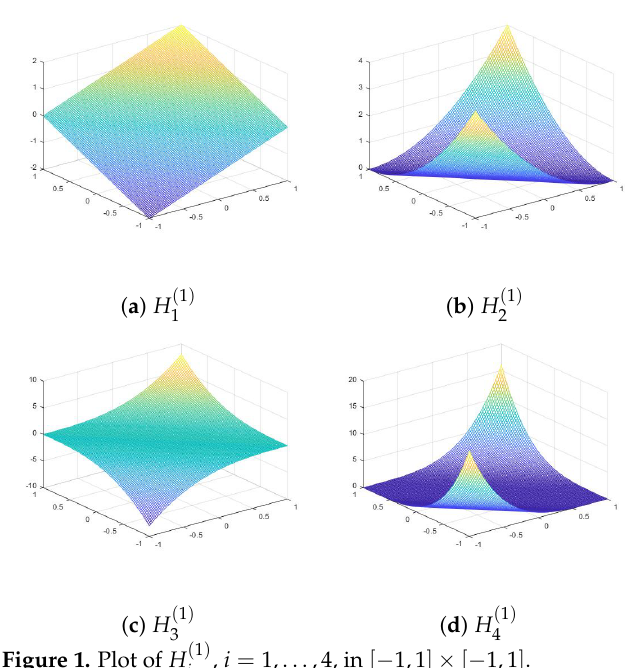
Figure 1. Plot of H